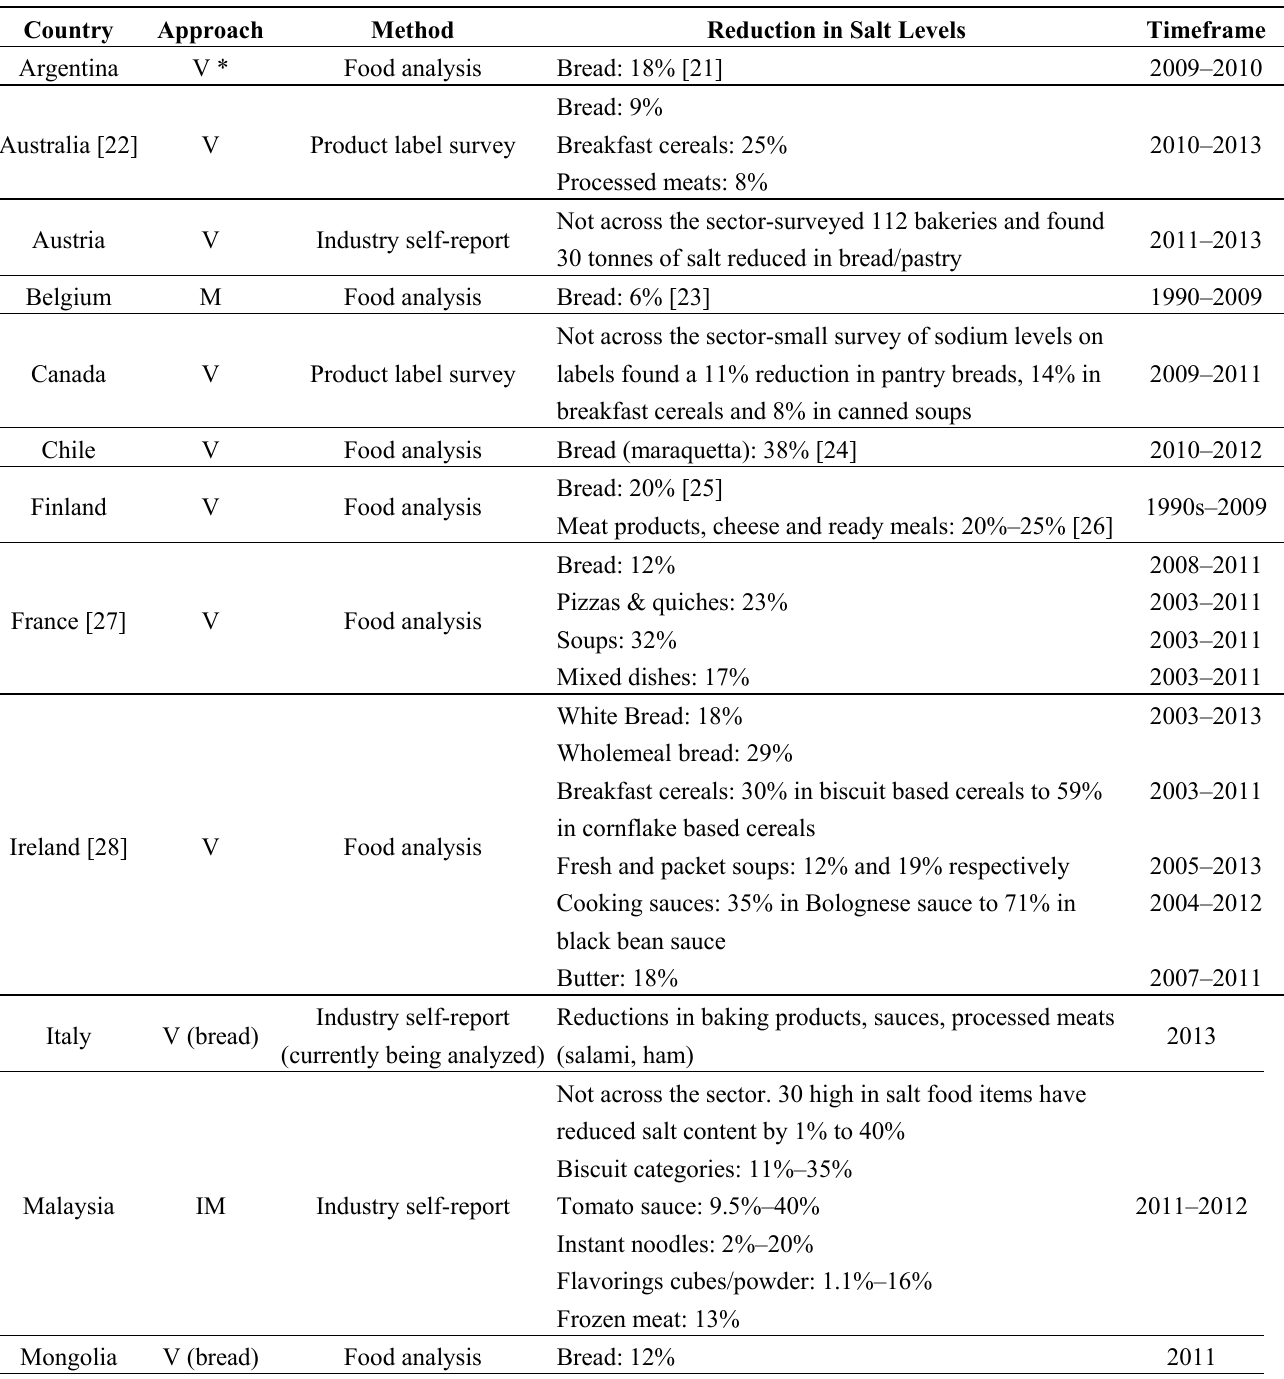
Table 2. Impact of programs of industry engagement on salt levels in